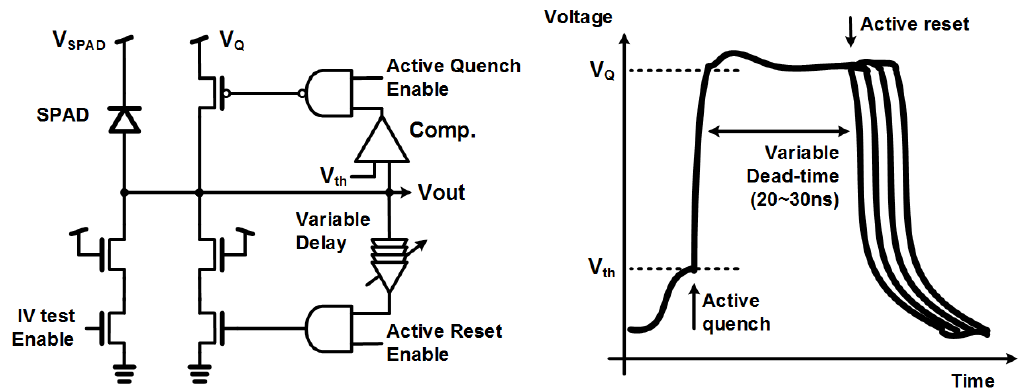
Figure 2. Circuit diagram of an active quenching and reset circuit (AQRC) and the simulated output waveform.